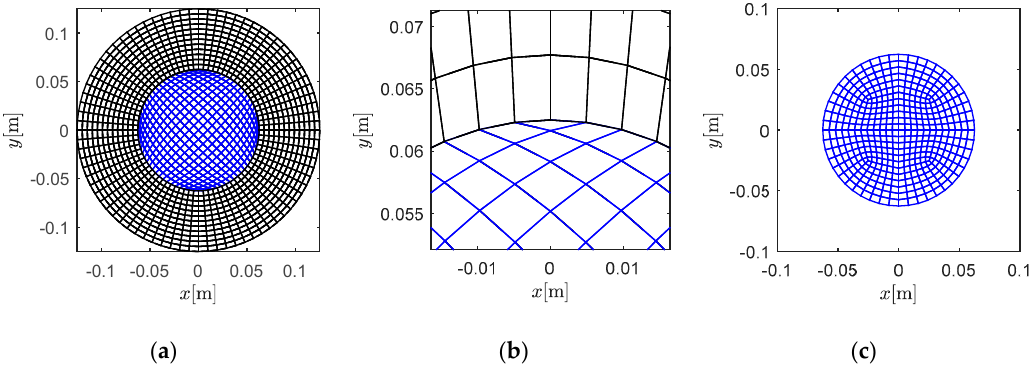
Figure 8. Grids investigated with curved interfaces: ( a ) the solid circular region divided by a curved interface, ( b ) detailed view of non-optimal mesh area, and ( c ) an alternative grid mode for the inner region.